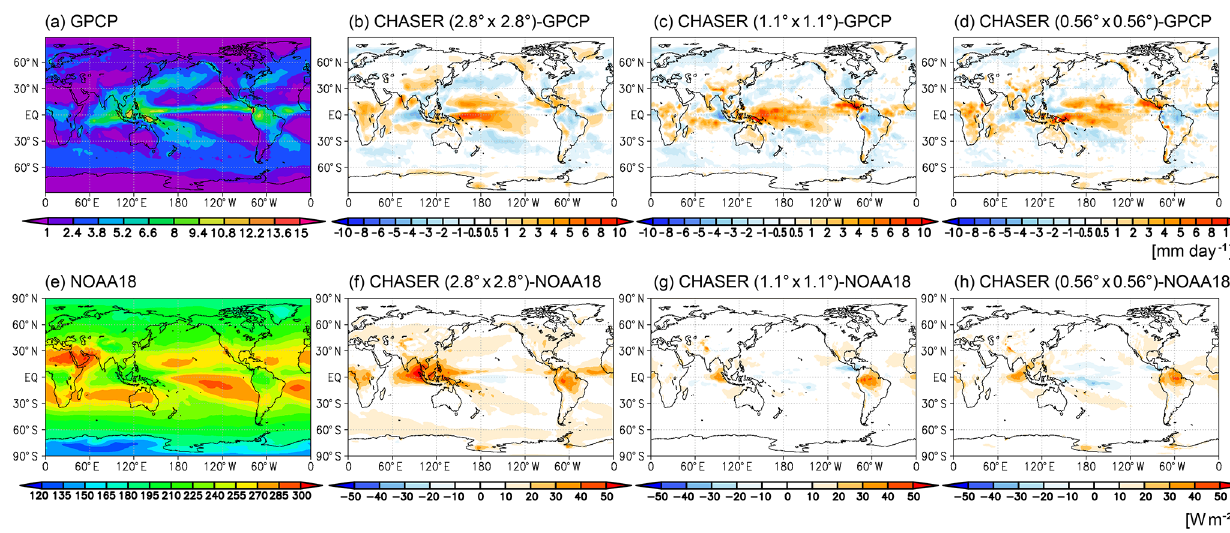
Figure 1. Annual mean precipitation rate (mmday − 1 ) from GPCP (a) and outgoing longwave radiation (OLR; Wm − 2 ) from NOAA 18 satellite (e) for 2008. The second, third, and fourth columns show differences in precipitation (b–d) and OLR (f–h) between the observations and the model simulations at 2.8 ◦ (b, f) , 1.1 ◦ (c, g) , and 0.56 ◦ (d, h) resolutions, respectively. The observations and model results are mapped onto 2.5 and 1 ◦ bin grids for precipitation and OLR, respectively.